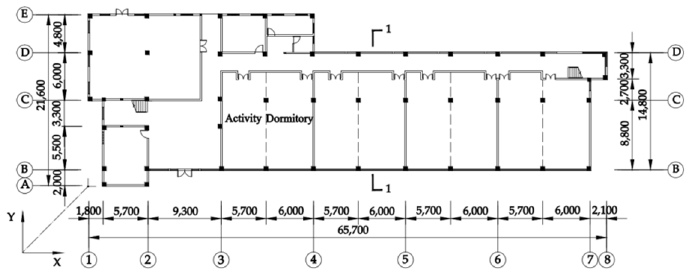
Figure 1. Ground floor plan (Unit: mm).